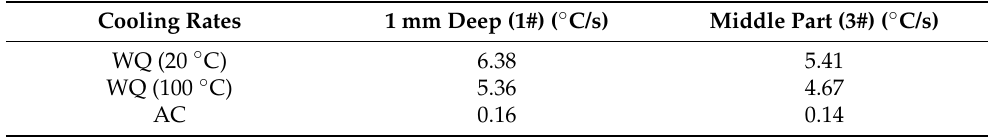
Table 1. Cooling rates in AC, WQ (20 ◦ C) and WQ (100 ◦ C). Cooling